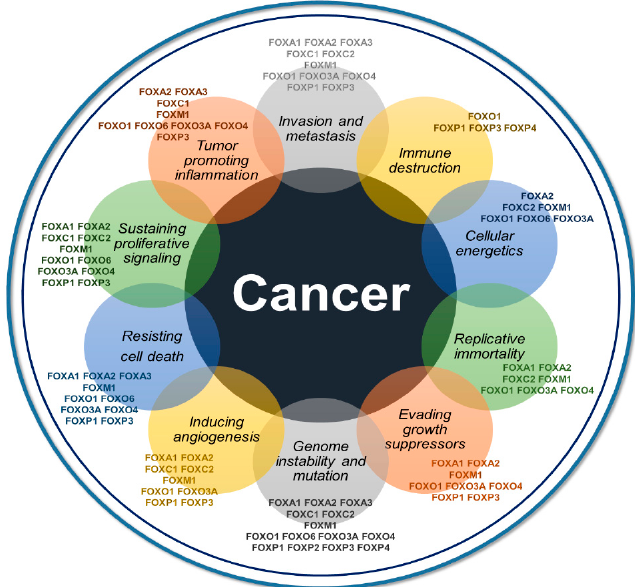
Figure 1. Direct and indirect associations of 14 individual FOX transcription factors and the hallmarks of cancer acquired from Cancer Hallmarks Analytics Tool. FOXO1 appears to be associated with every hallmark while FOXM1, FOXO3a, FOXA2, and FOXP3 are connected to at least eight hallmarks of cancer. FOXP2 is only related to genome instability when FOXP4 is involved in the genome instability and immune destruction process.